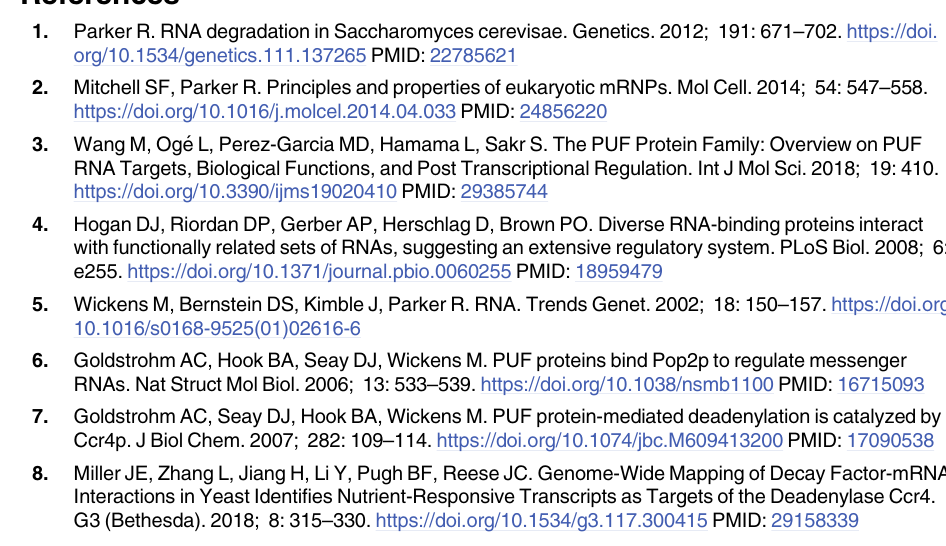
protein level. Fold change is presented in Fig 13C. (D, E) The comparison of the Ixr1 protein level (D) and quantitative analysis data of Ixr1-HA protein (E) between the synchronized bar1 Δ cell and bar1 Δ puf5 Δ mutant harboring the YCplac33- IXR1 -HA- IXR1 3´ UTR plasmid. 100 min samples of each strain were loaded. The arrowheads show three different bands of Ixr1-HA protein observed. Band 1 and band 2 were quantified and normalized with the Pgk1 protein level. The data shows the fold change of Ixr1-HA protein relative to the protein level in the bar1 Δ cell